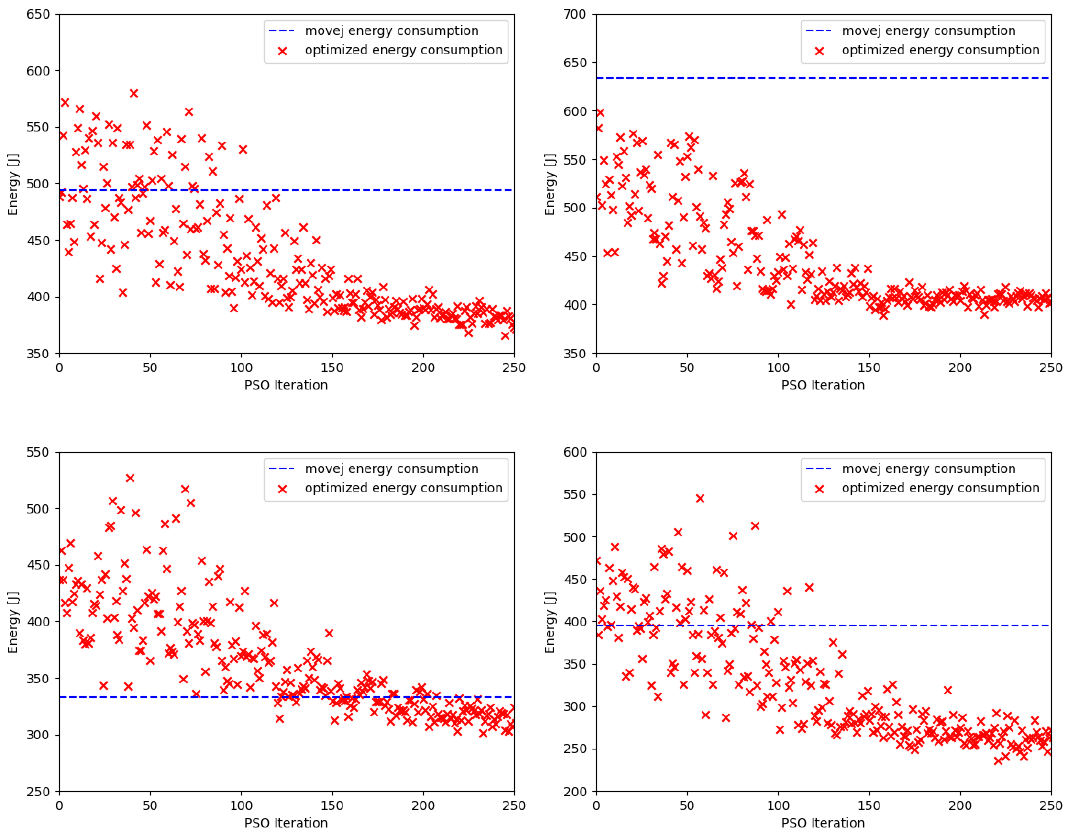
Figure 4. Convergence of particle swarm optimization (PSO) optimizations. The blue line represent default energy consumption by individual PTP movement, red crosses are energies consumed by execution of optimized